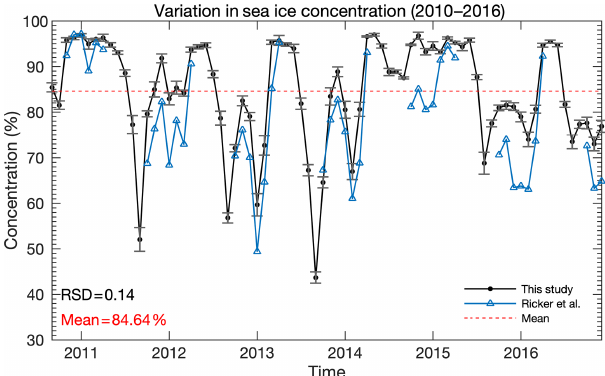
Figure 6. CMST sea ice concentration averaged over the entire Fram Strait gate, from September 2010 to December 2016. The black dotted line represents monthly mean ice concentration based on CMST data with corresponding standard deviations while the blue dotted line represents monthly mean ice concentration of OSI SAF.